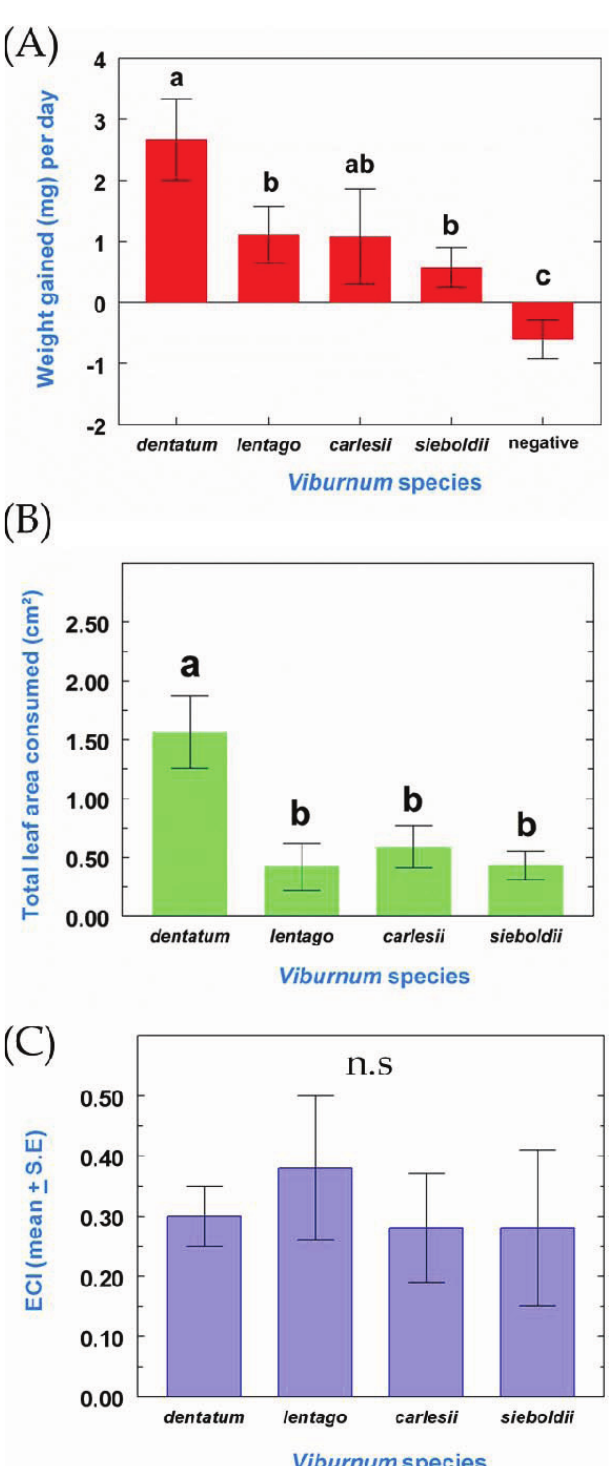
Figure 2. ( A ) Daily weight gained (mg), ( B ) total leaf area consumed, and ( C ) efficiency of conversion of ingested food (ECI) ( i.e. , total weight gained/total weight ingested) by P. viburni 3rd instar larvae after transfer from an optimal host species ( V. dentatum ) to the same host or to a suboptimal host ( V. dentatum , n = 10; V. lentago , n = 10; V. carlesii , n = 13; V. sieboldii , n = 9) (mean ± SE). In the “negative” treatment ( A ), P. viburni larvae were not provided any food. Means followed by a different letter are statistically different (One-way ANOVA, LSD all-pairwise comparisons, p < 0.05). n.s. =